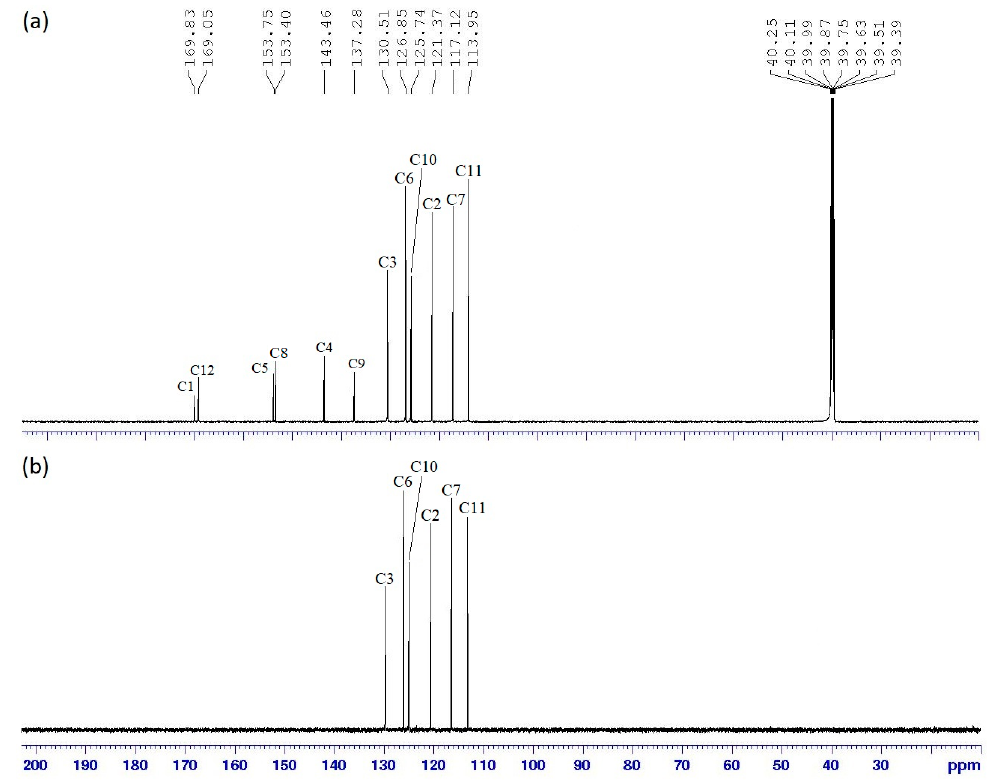
Figure 9. ( a ) 13 C-NMR and ( b ) DEPT- 45 spectra of compound 8j .